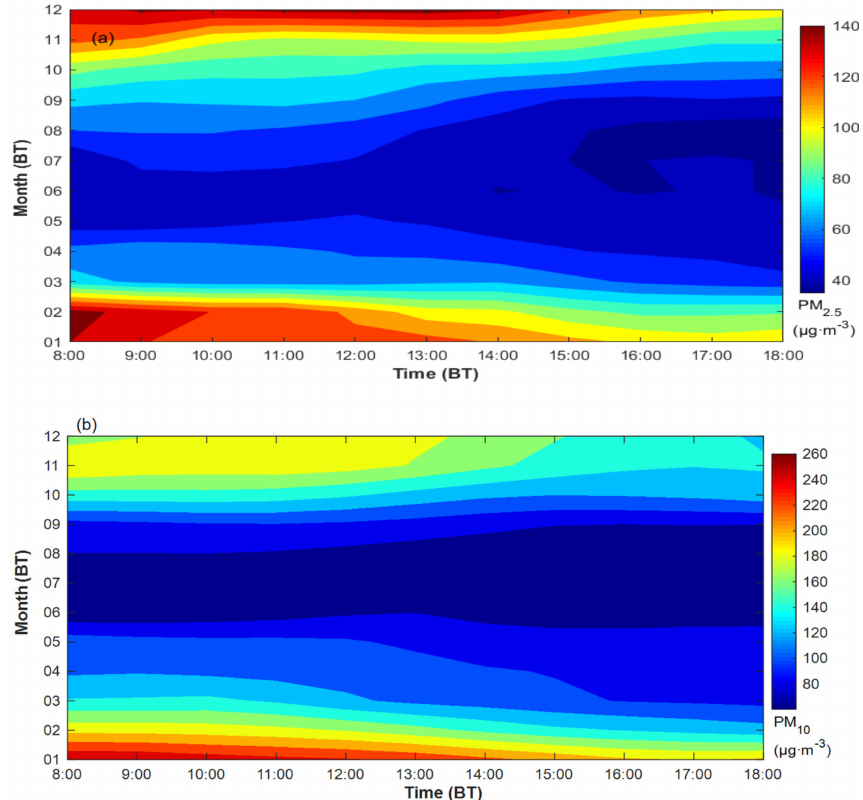
Figure 10. ( a ) The temporal distribution of average PM 2.5 during haze events in different months; ( b ) The temporal distribution of average PM 10 during haze events in different